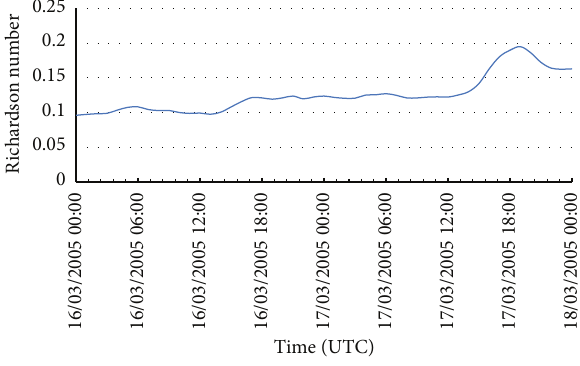
Figure 3: Temporal variation of the Richardson number, as this was calculated for the stable period 16–18 March 2005 at 00:00 UTC.